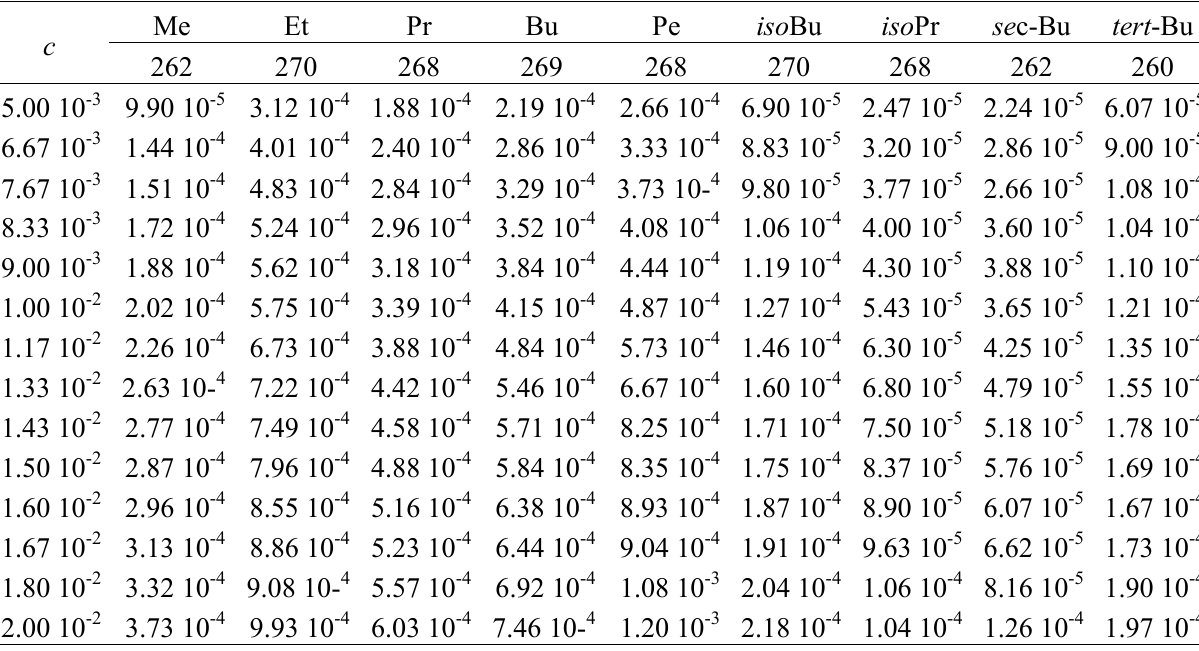
Mean values (from three measurements) of observed rate constants k acetoxymercuration of α -alkylstyrenes depending on mercuric acetate concentration c (mol·dm –3 ) in acetic acid at 25.0 °C; the values in the second line are the wavelengths λ (nm) at which the measurements were carried